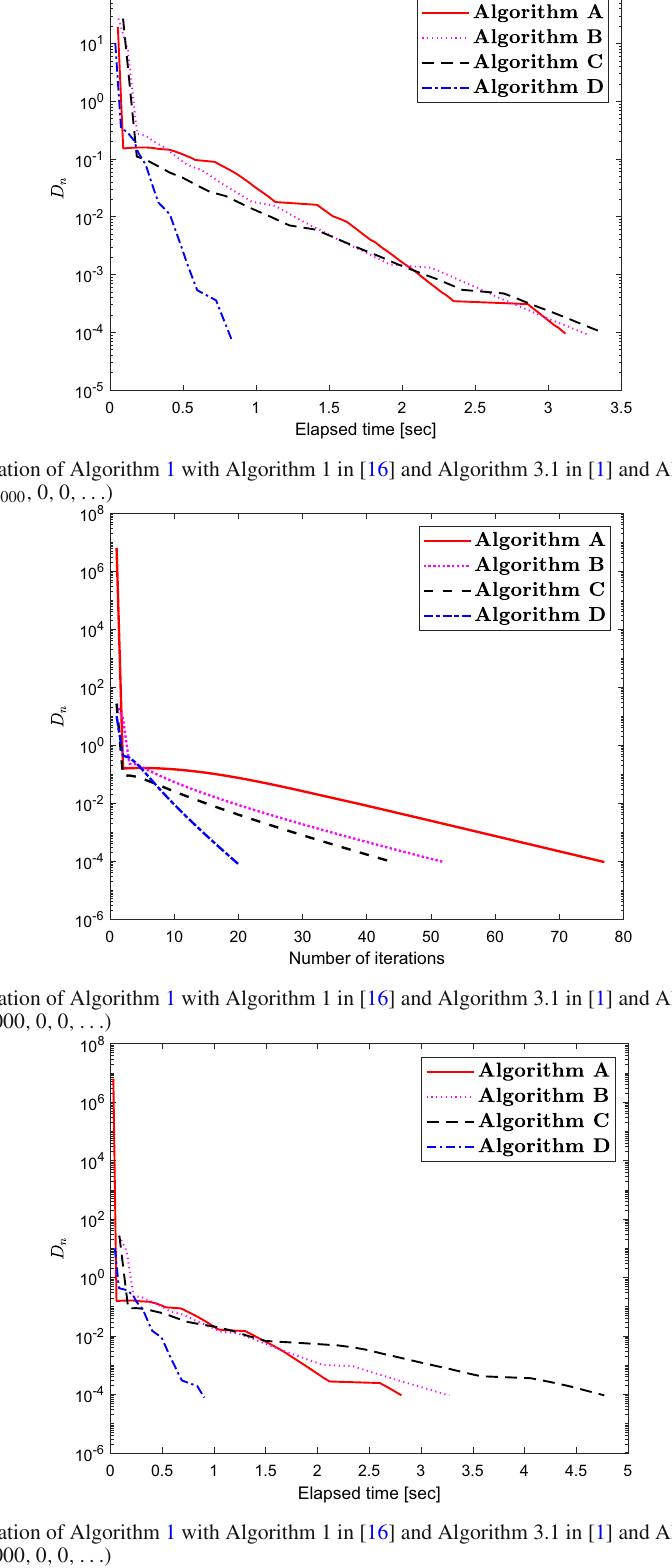
Fig. 8 Numerical illustration of Algorithm 1 with Algorithm 1 in [16] and Algorithm 3.1 in [1] and Algorithm 3.1 in [27] while u 0 = u 1 = ( 1 , 2 ,..., 5000 , 0 , 0